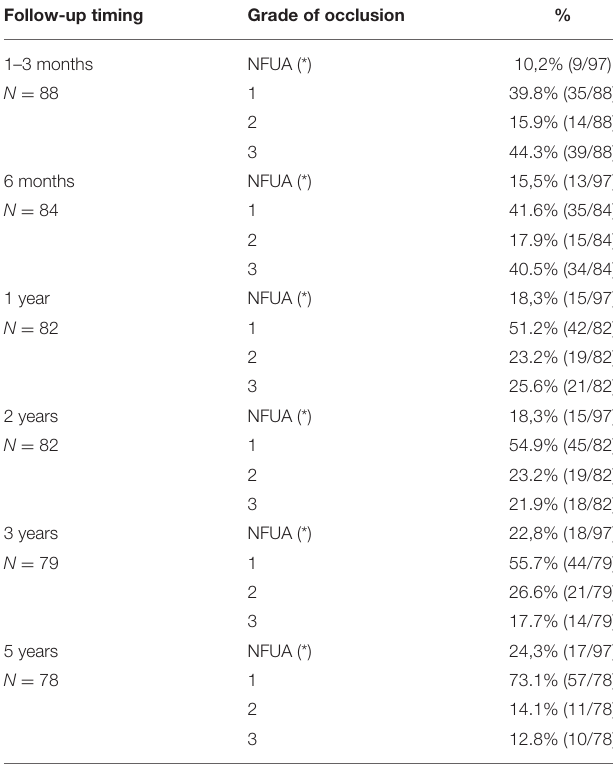
TABLE 3 | Radiographic outcomes of aneurysms treated with LEO